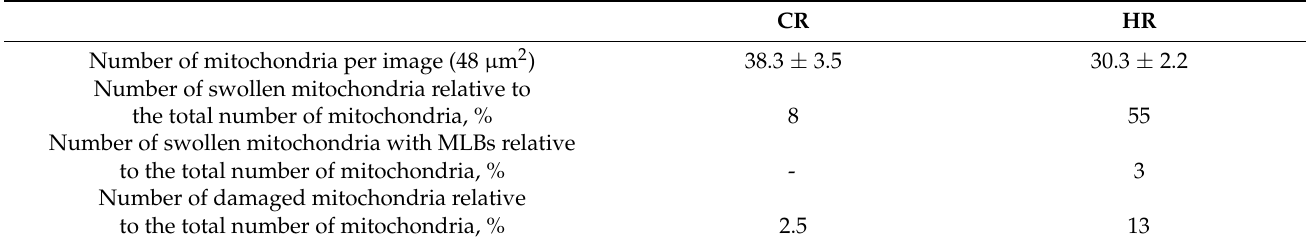
Table 3. Morphometric parameters of heart mitochondria in the control and hyperthyroid rats. CR HR 38.3 ± 3.5